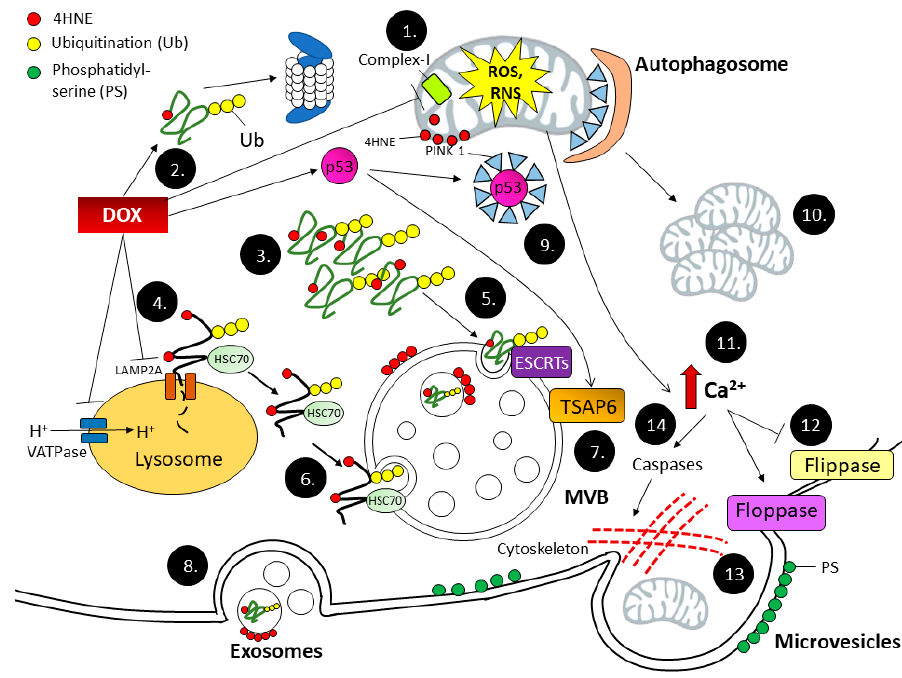
Figure 1. Dox inhibits intracellular protein quality control pathways while promoting extracellular vesicle release. vesicle